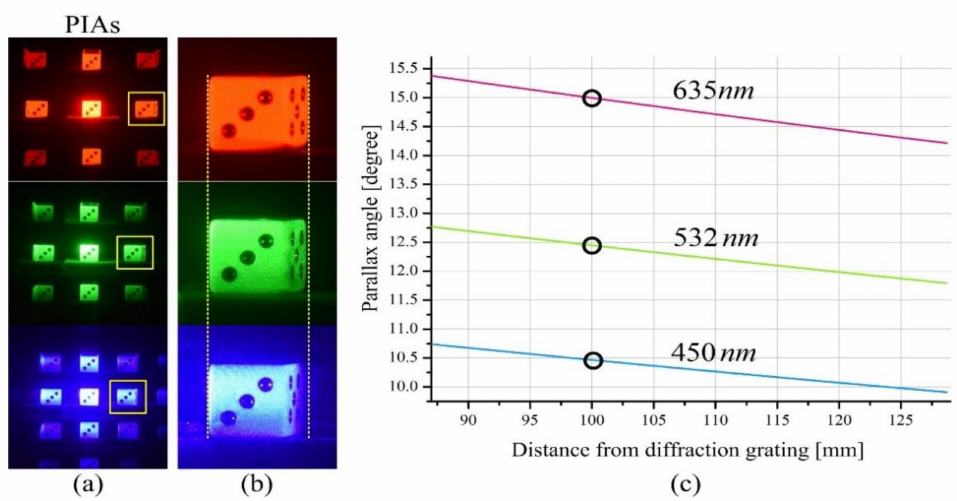
Figure 5. Parallax angles vs depth and wavelengths. ( a ) Parallax image arrays (PIAs) of wavelengths of red (635 nm), green (532 nm), and blue (450 nm). ( b ) Enlarged views of the parallax images by the 1st order diffraction. ( c ) Parallax angle graphs for each wavelength with an increase in the object